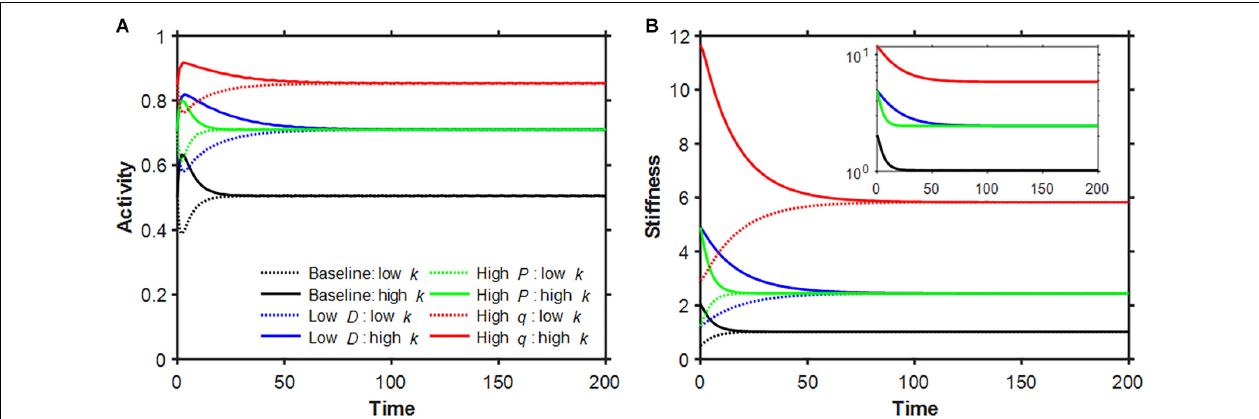
FIGURE 1 | Time evolution of non-dimensionalized activity (A) and stiffness (B) . Baseline model parameters in these simulations were q = 0.2, D = 0.32 and P = 0.1 (black) corresponding to the dimensionless variables activity threshold, digestion rate and production rate, respectively. Additional simulations with low D (blue), high P (green) and high q (red) are also shown. The initial conditions were set to the fixed point in activity and half (solid dotted line) or double (solid line) the value of the corresponding stiffness fixed point. The inset plots the stiffness decays on a logarithmic scale. The dimensional parameters α , A and Q were set to unity.